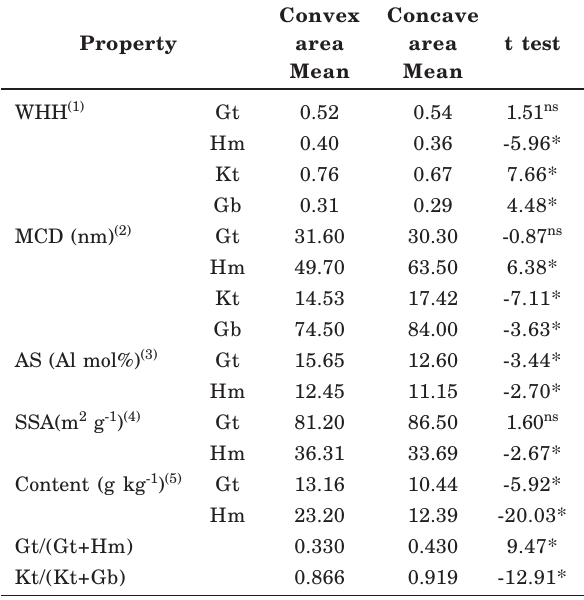
Table 4. Mean values of the studied properties in the convex and concave